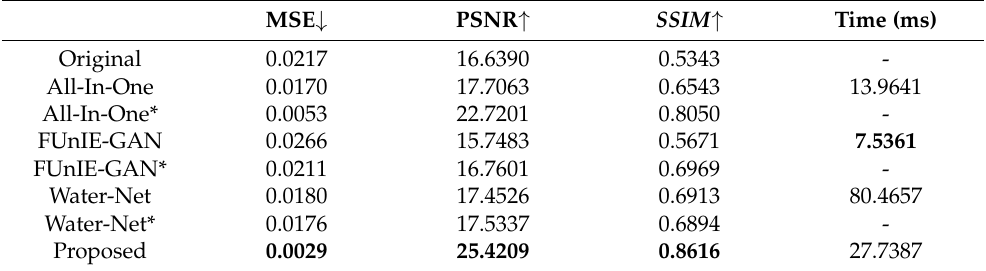
Table 4. Quantitative evaluation on simulated underwater images. ↓ means smaller scores are better. ↑ means larger scores are